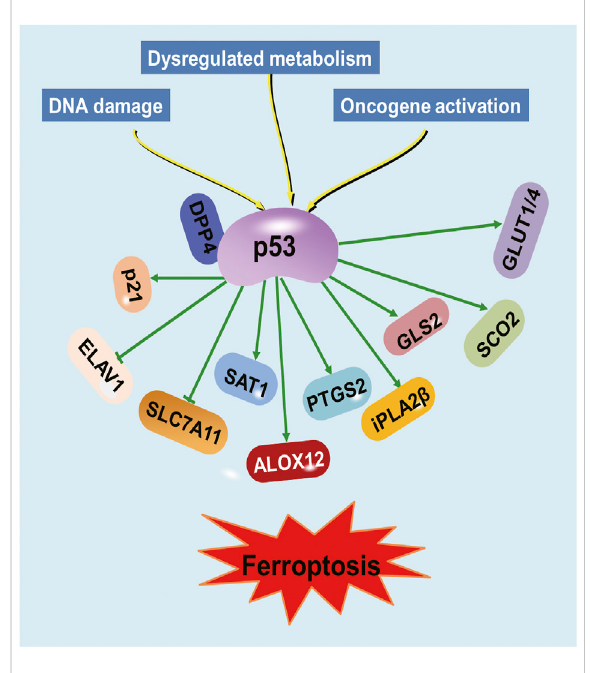
FIGURE 1 Regulation of ferroptosis by p53. Various proteins involved in iron metabolism and lipid peroxidation are modulated by